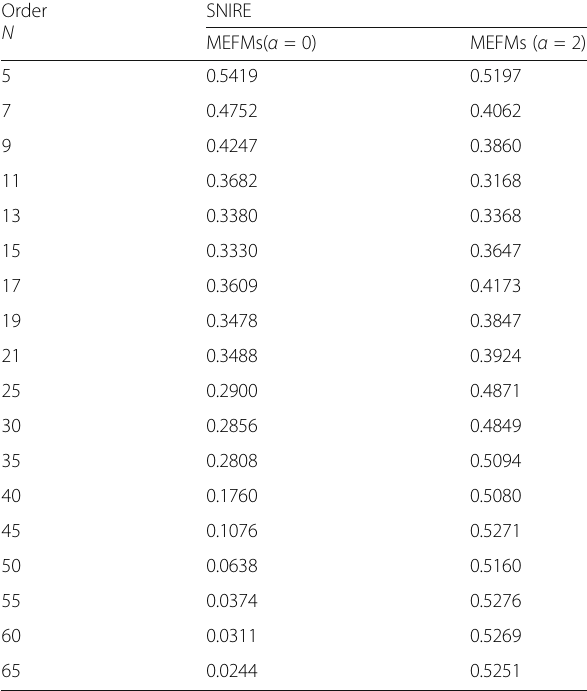
Table 2 Uppercase English letter “ E ” are reconstructed in parameters ( α = 0 and α = 2) under different order moments Order